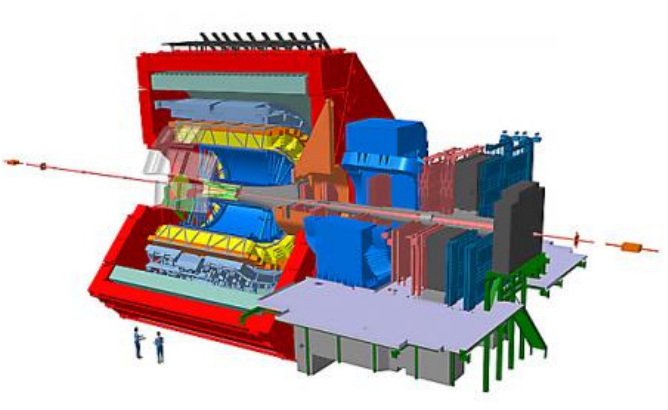
Figure 1. Schematic view of the upgraded ALICE